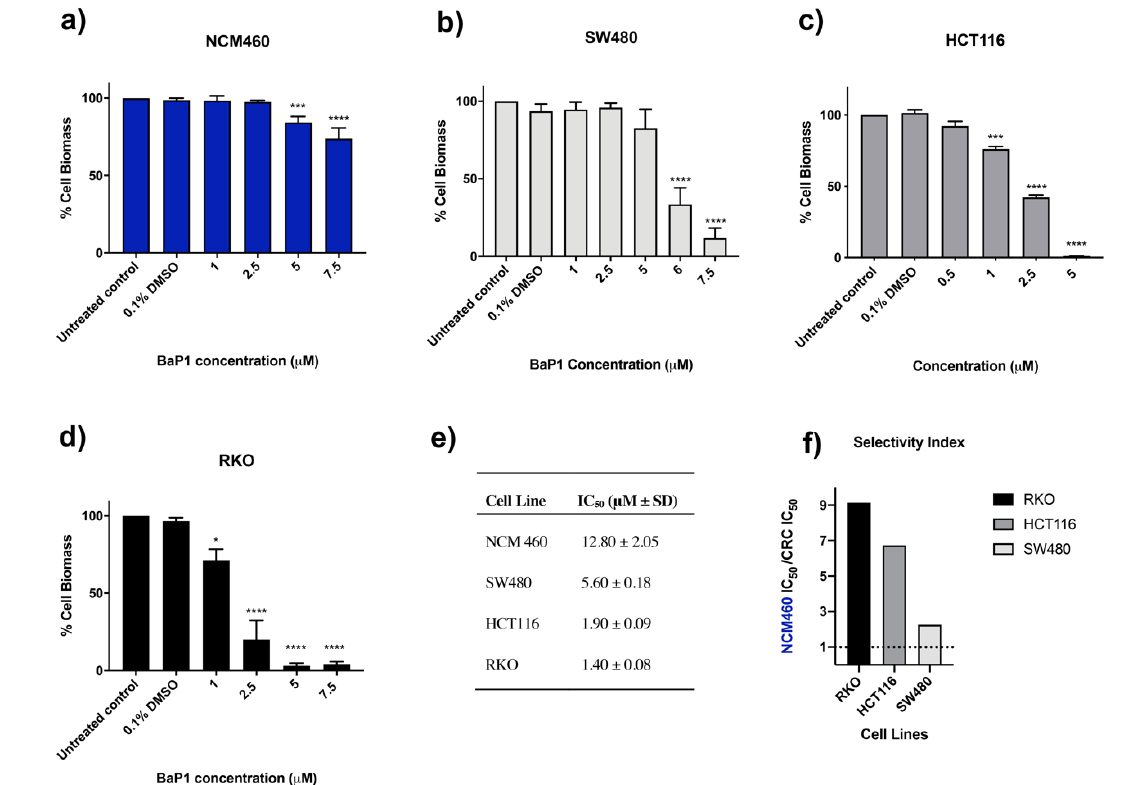
Figure 2. Effect of BaP1 on cell viability of ( a ) NCM460, ( b ) SW480, ( c ) HCT116, and ( d ) RKO cell lines. Cell lines were exposed to increasing concentrations of BaP1 or DMSO (0.1%) for 48 h. After the incubation, cell biomass was assessed by sulforhodamine B (SRB) assay. Values are means with SD (n ≥ 3). Statistical analysis was performed by one-way ANOVA. * p < 0.05, *** p < 0.001, **** p < 0.0001. ( e ) IC 50 values determined after the respective incubation time. ( f ) In vitro selectivity index (NCM460 IC 50 /CRC cell lines IC 50 ). A broken line at selectivity index = 1 represents no difference in IC 50 between tumor and normal cells.